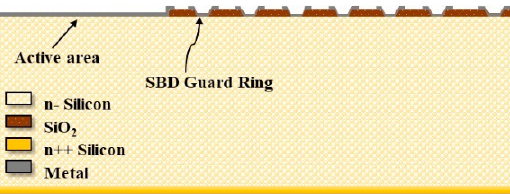
Figure 1. Simulation geometry, 2 − D view of half − infinite and symmetric conventional SSBD structure consisting of a Schottky diode as the sensor surrounded with 7 guard rings.